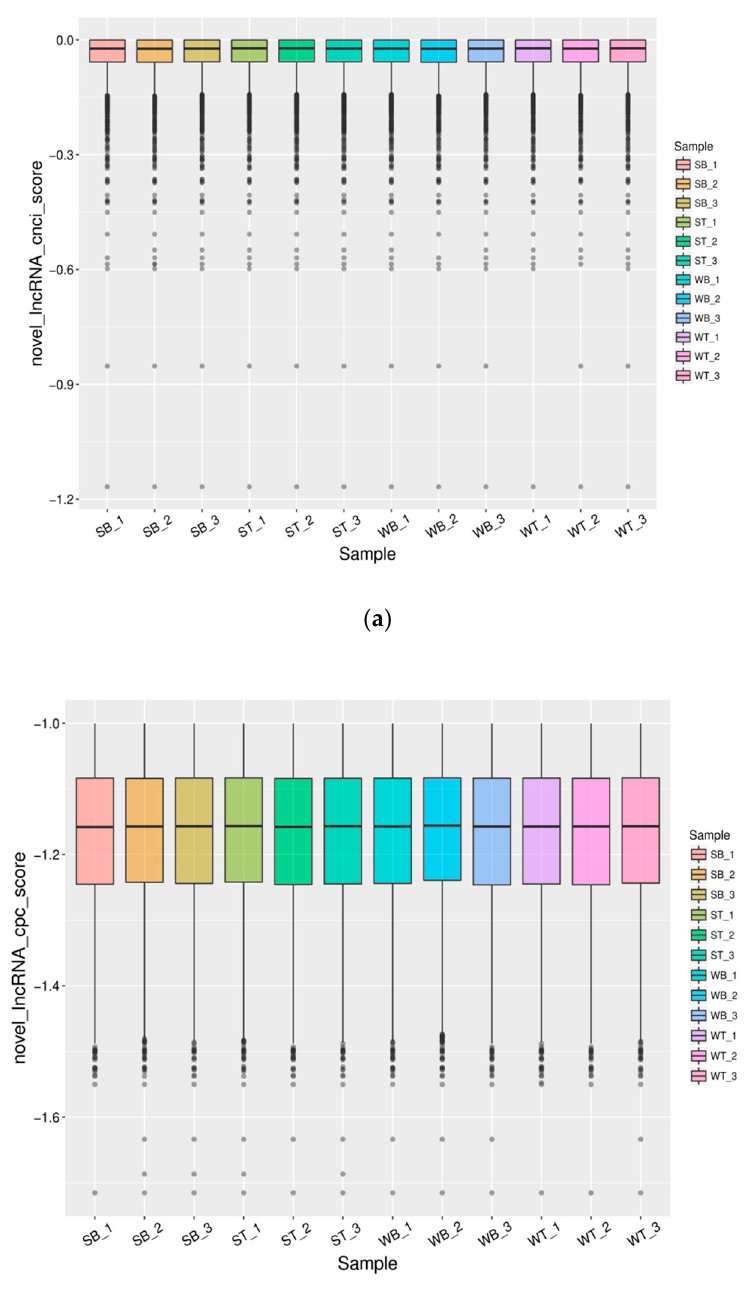
Figure 1. Boxplot of the novel lncRNAs prediction score ( a ): Novel lncRNAs prediction score wih CNCI software (Version 2, GitHub, San Francisco, CA, USA). ( b ): Novel lncRNAs prediction score wih CPC software (Version 2, CBI, USA).